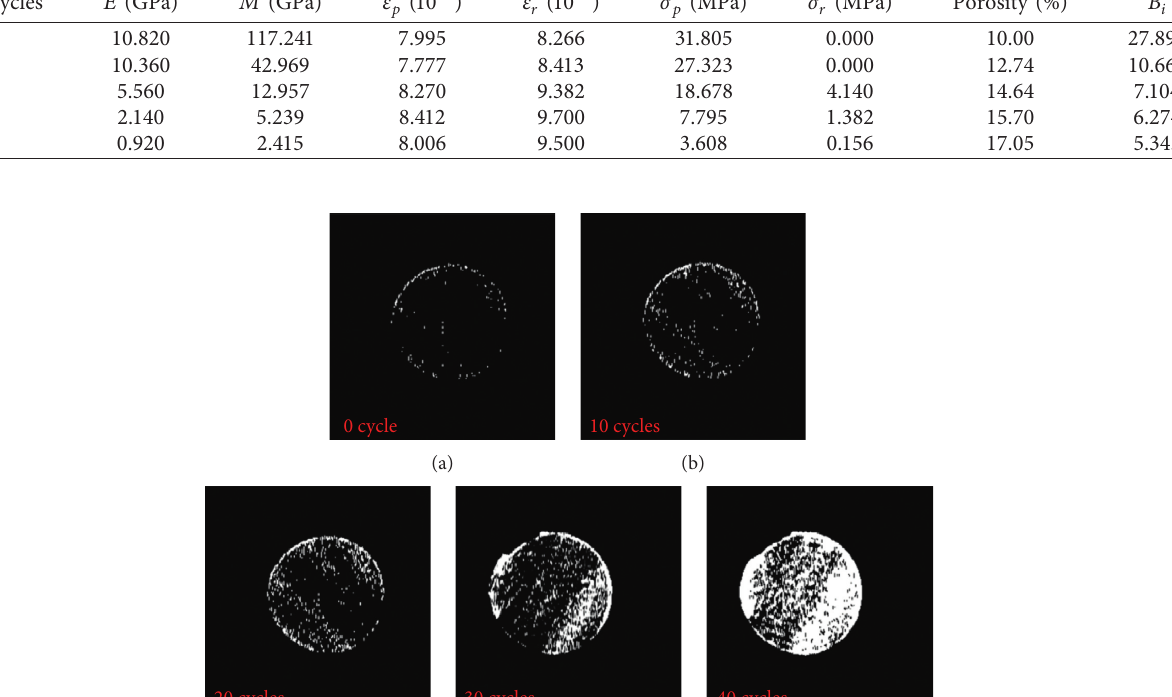
Figure 12: Typical strain-stress curves of sandstone underwent various F-T Table 1: Mechanical parameters, porosity, and brittleness index values of the samples subjected to various F-T cycles. F-T cycles